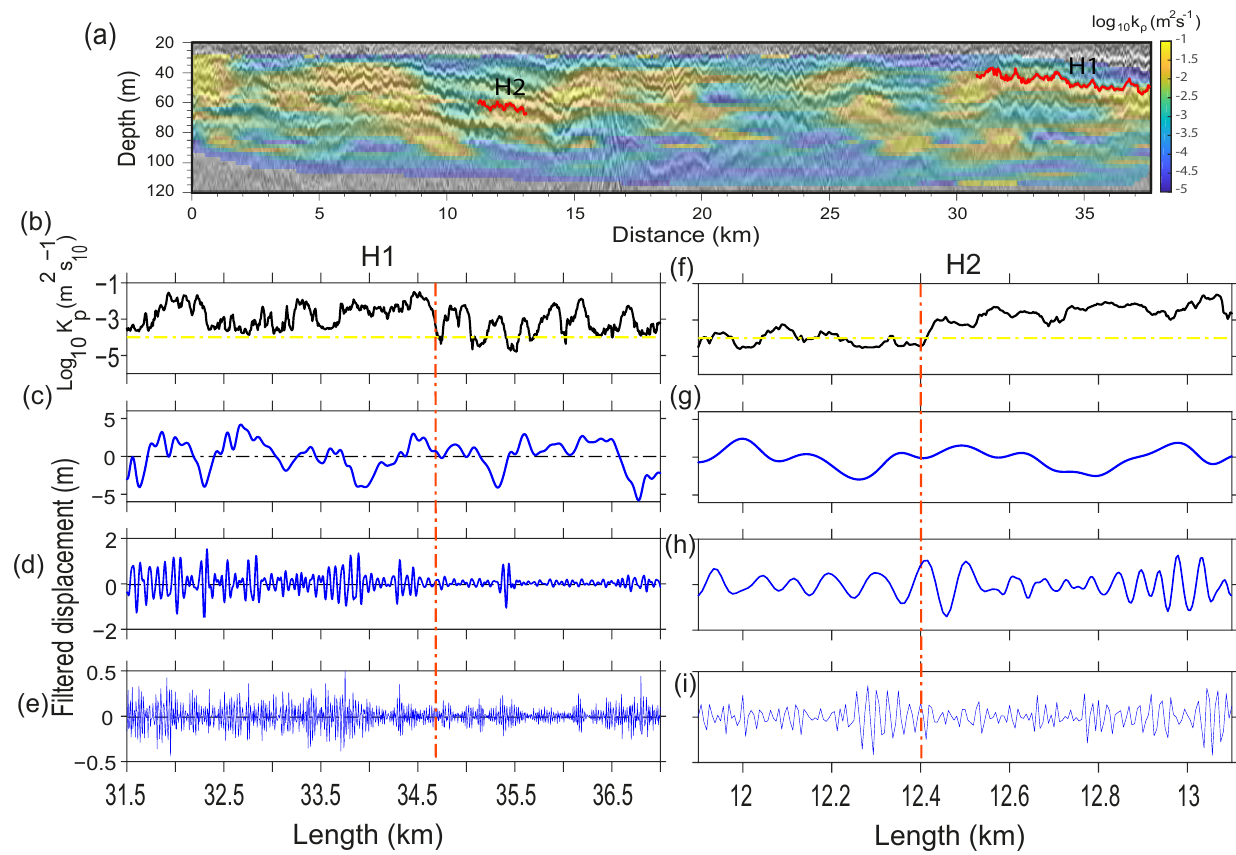
Figure 7. (a) High-resolution k ρ (x,z) map overlapped with the HR-MCS image. Red lines indicate the locations of the two horizons analyzed (H1 and H2). They have been selected as examples of reflectors crossing higher mixing areas. (b) Diapycnal mixing obtained along H1 (see details of calculation in the text). (c) Signal filtered at wavelength ranges of the IW subrange (3000–100m), (d) the transi- tional subrange (100–30m), and (e) the turbulent subrange (30–13m). The dashed red lines identify the “breaking point” referred to in the text. (f, g, h, i) Same as (b, c, d, e) but for